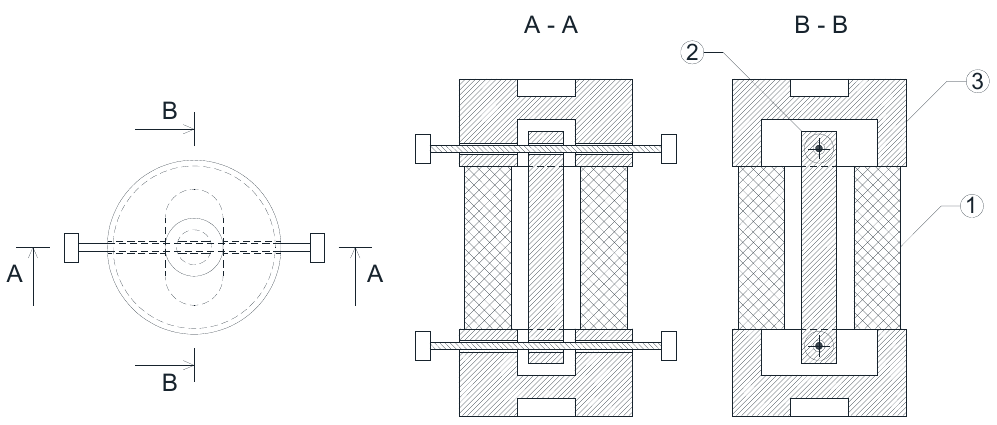
Figure 4. Technical sketch of the polymeric bearing (PB) (1: polymer cylinder with a centrally located hole, 2: pin-ended steel core, 3: anchor plate).